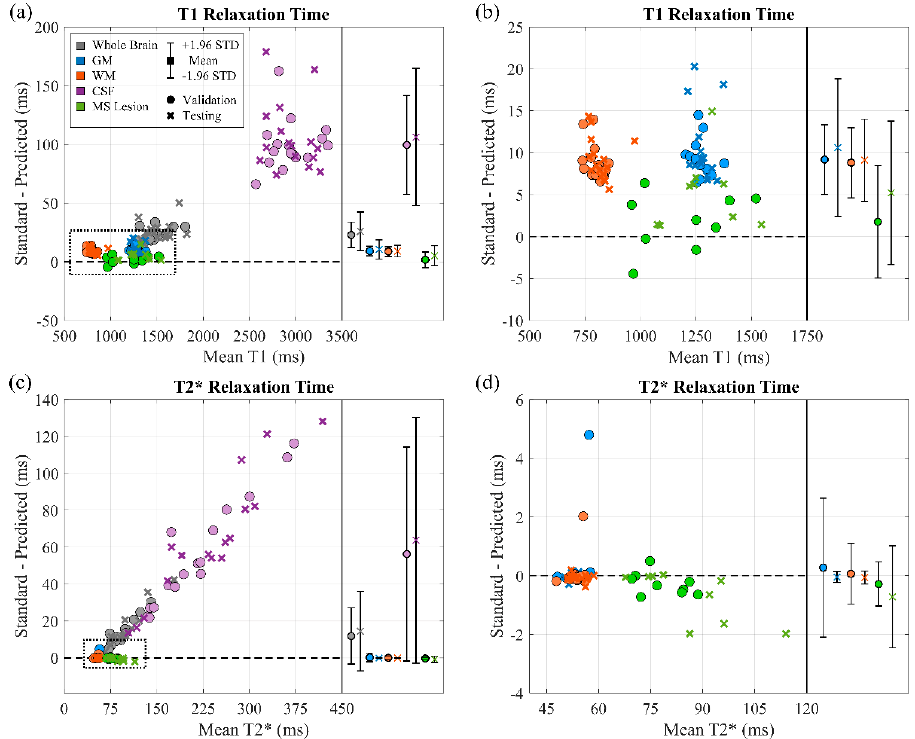
Figure 6. Bland-Altman plot for mean T1 and T2* relaxation times of 32 subjects (18 with MS lesions) for the whole brain and different tissues. ( a , c ) Plot for all tissues. ( b , d ) Cropped views of GM, WM, and MS lesion shown in ( a ) and ( c ).